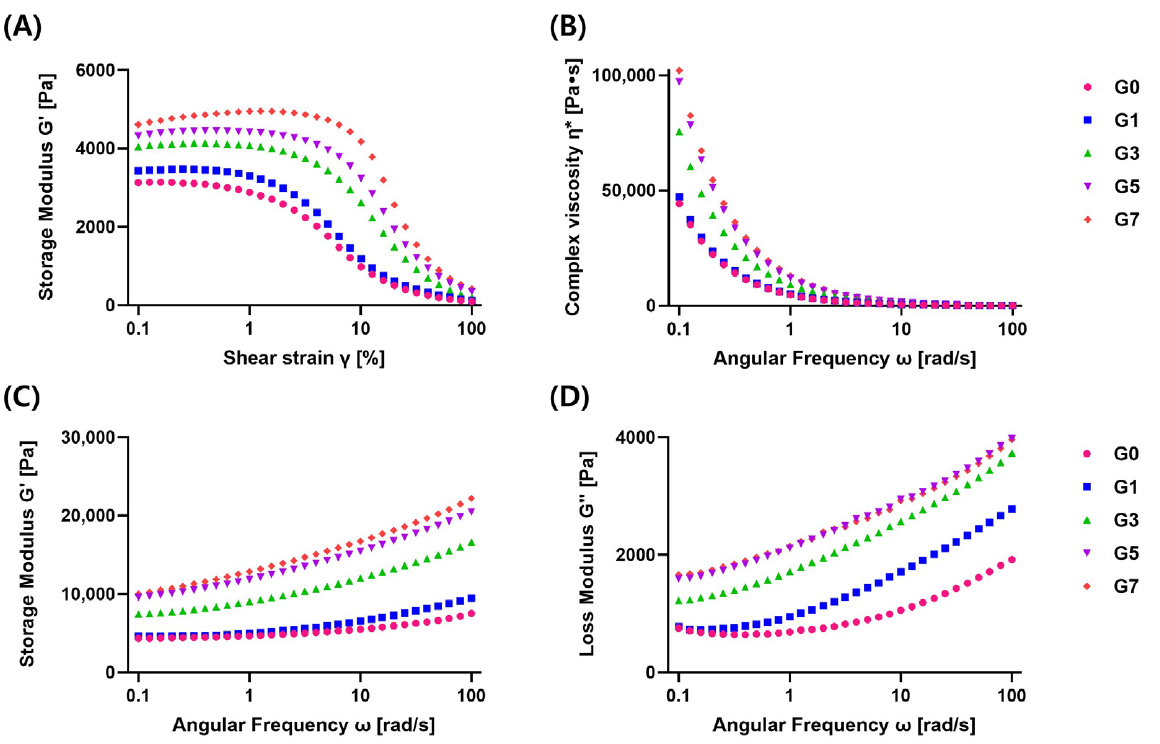
Figure 3. Linear viscoelastic region (LVE) during an amplitude sweeps test ( A ). Complex viscosity ( η *), storage modulus (G’), and loss modulus (G’’) during an angular frequency sweep test ( B , C , and D , respectively) for abalone 3D print ink containing different concentrations of gelatin (0–7%).